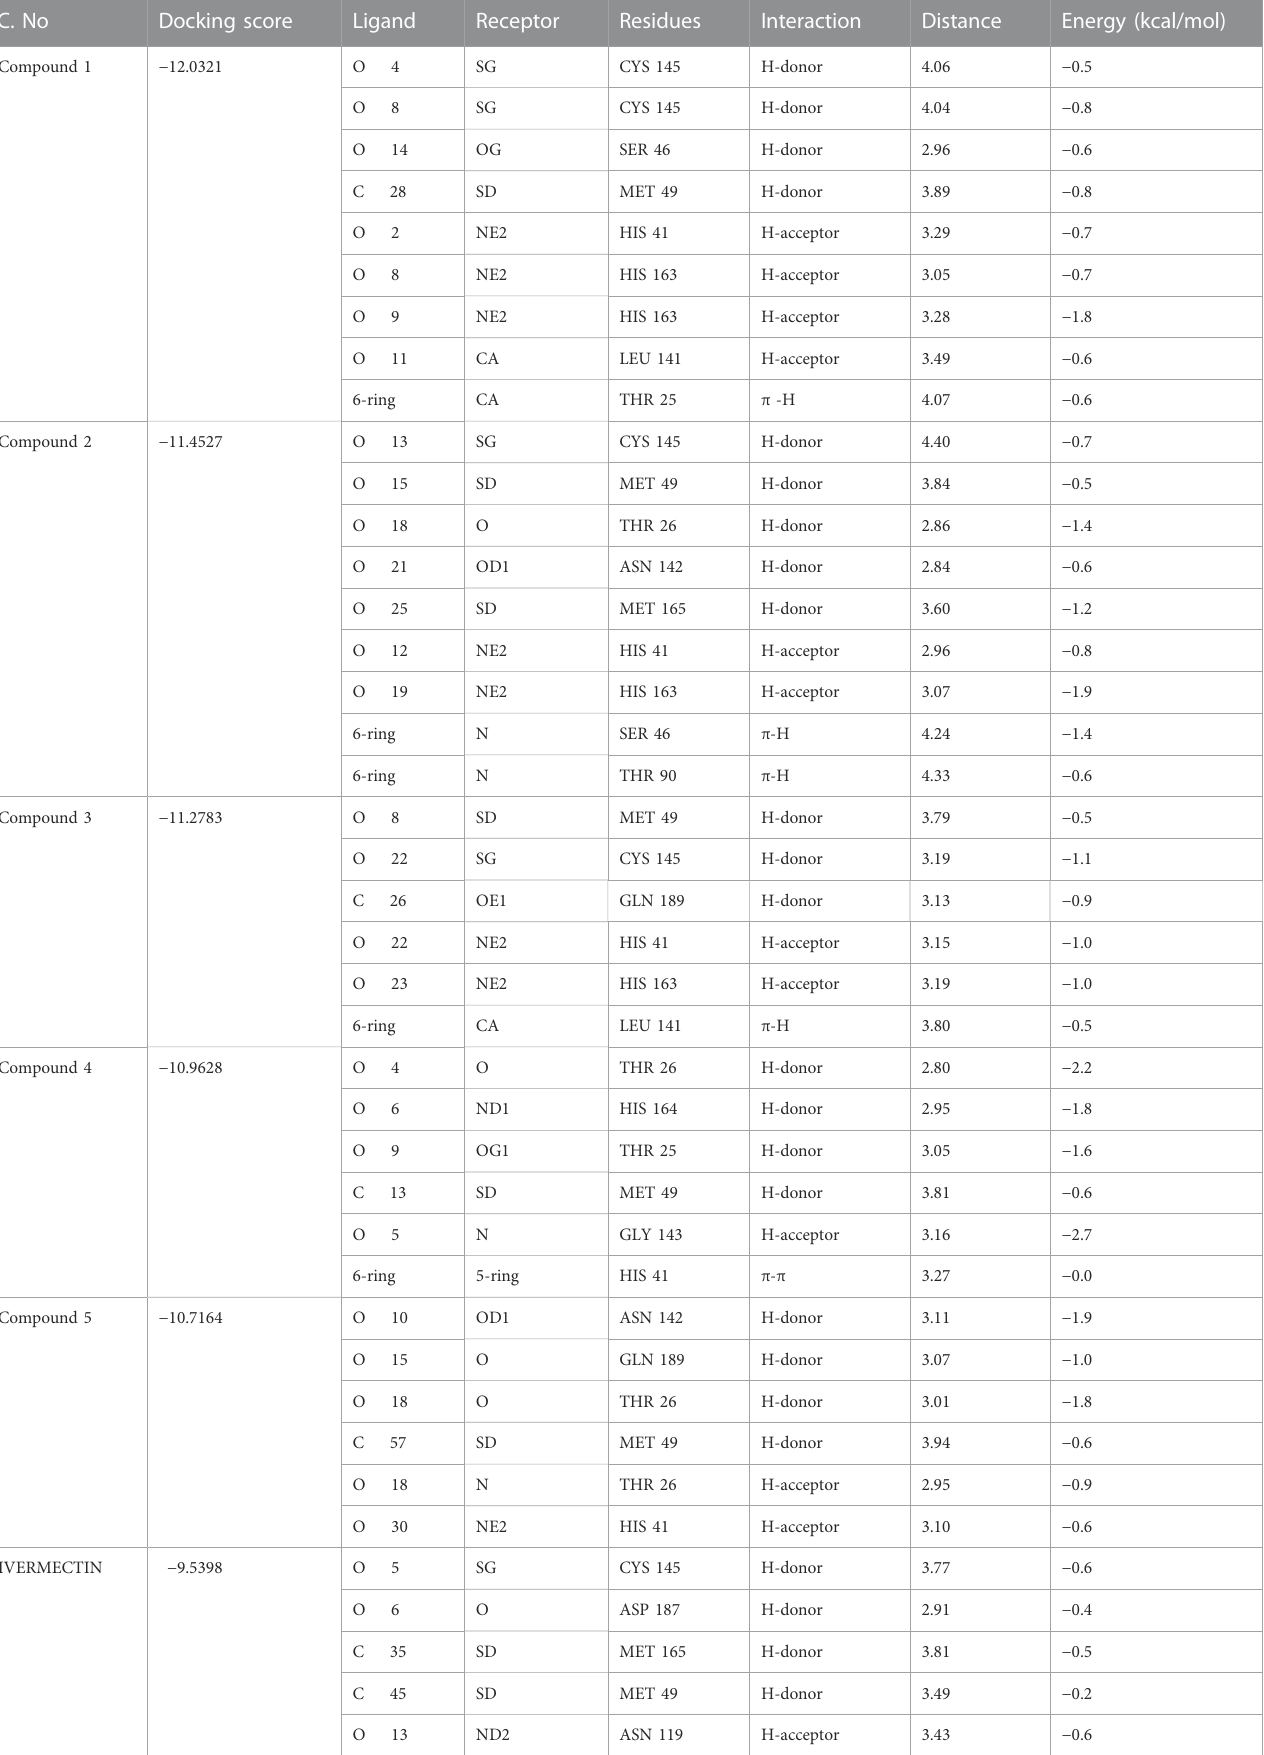
TABLE 5 Docking score and interaction of top fi ve hits against the 3CL pro . C.